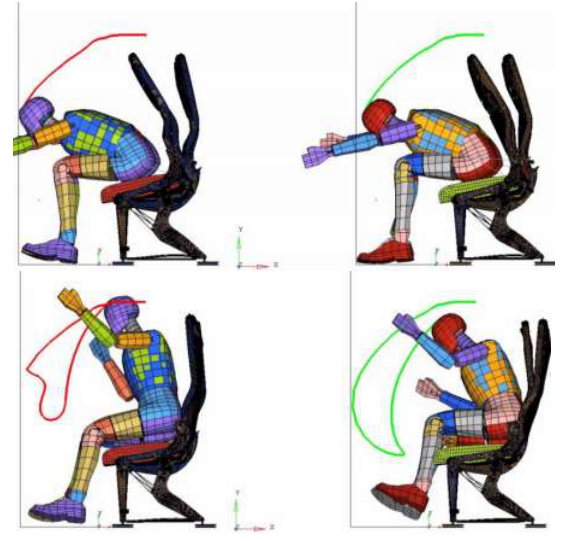
Figure 10. Head displacements for preliminary (on the left) and new (on the right) FE models.